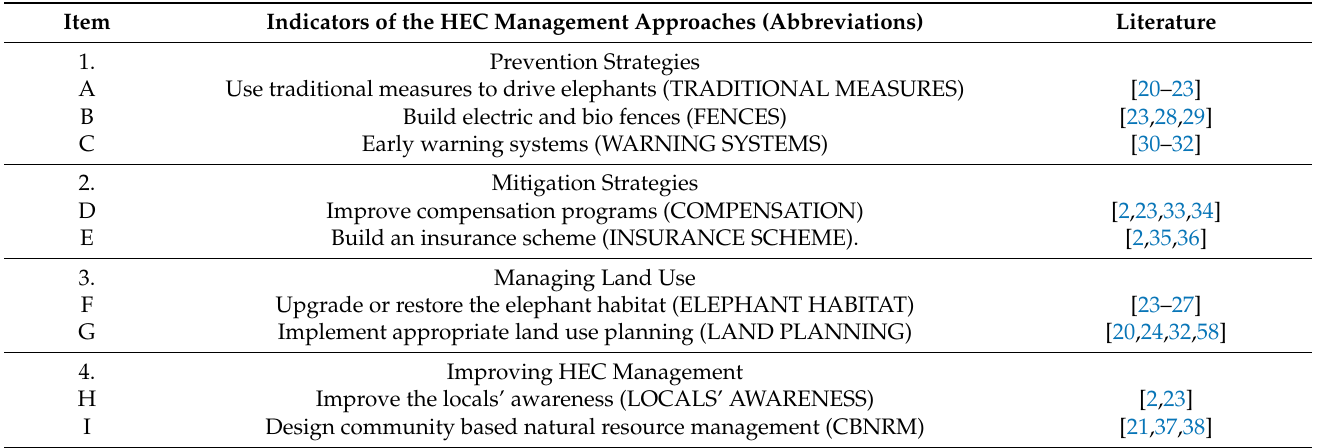
Table 1. Indicators of the HEC management